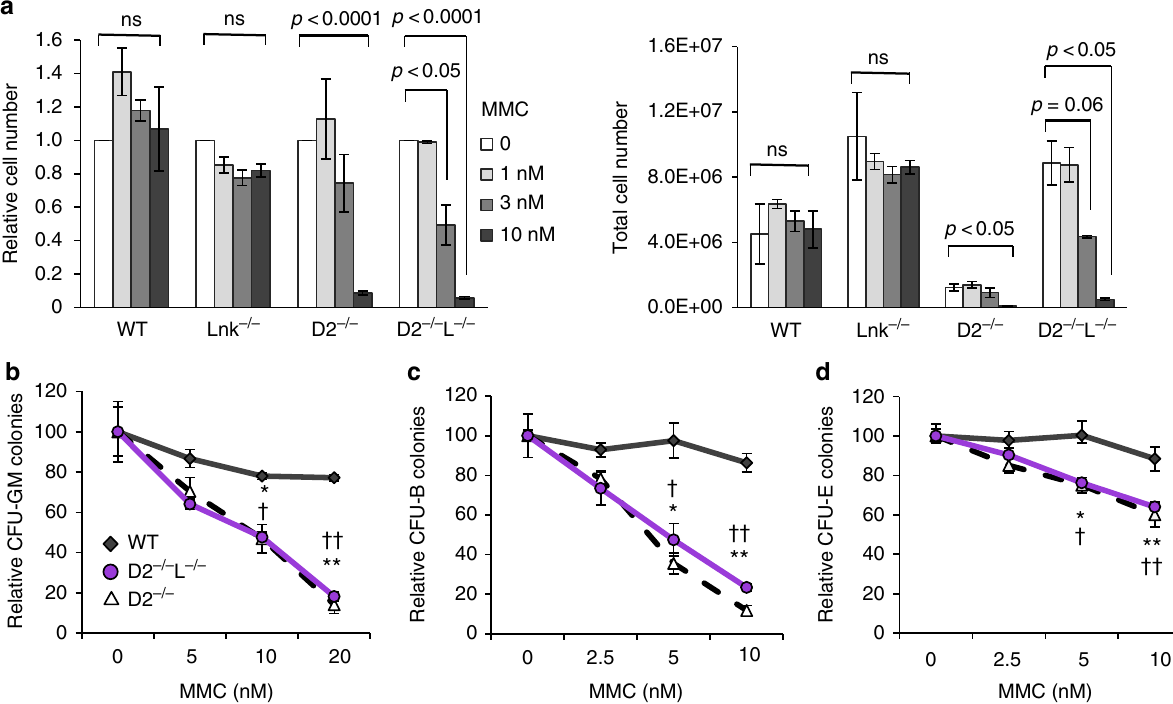
Fig. 3 Lnk de fi ciency does not rescue ICL hypersensitivity associated with Fancd2 de fi ciency. a HSPCs were cultured in a graded concentration of MMC for 7 days. Total (right) and relative to untreated cell number (left) are shown. Statistical analysis using two-tailed Student ’ s t -test of comparisons among untreated and MMC-treated cells within each genotype are indicated. b – d Fresh BM cells were plated in semi-solid methylcellulose media containing various concentrations of MMC and assessed for progenitors of myeloid ( b ), B cell ( c ), and erythroid lineages ( d ). Relative colony forming units relative to untreated are shown. * p < 0.05, ** p < 0.01, two-tailed Student ’ s t -test, denotes comparison between WT and D2; † p < 0.05, †† p < 0.01, denotes WT vs DKO, at the corresponding dose of MMC. Representative data from three independent repeats are